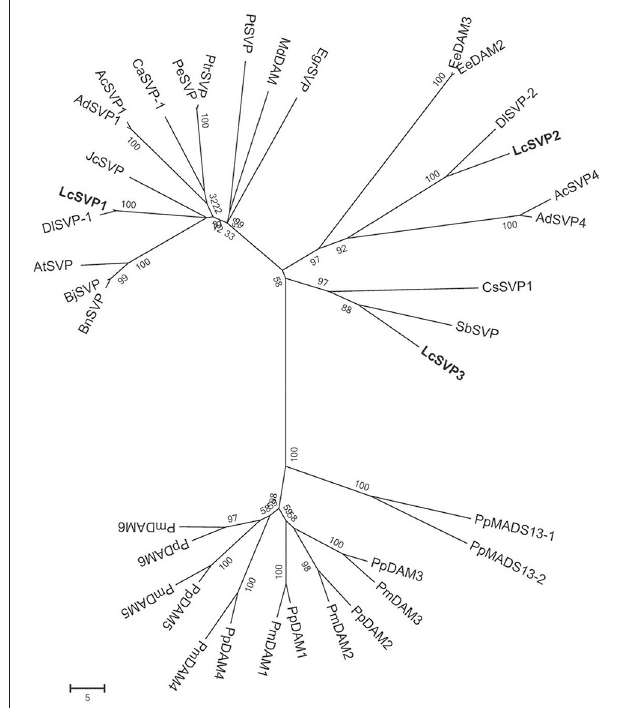
FIGURE 10 | Phylogenetic relationships between LcSVPs and SVPs of other species. The accession numbers of these proteins in the GenBank database are as follows: Actinidia chinensis (AcSVP1; AFA37967; AcSVP4, AFA37970); Actinidia deliciosa (AdSVP1, AFA37963; AdSVP4, AFA37966); Arabidopsis thaliana (AtSVP, AFU85632); Brassica juncea (BjSVP, AFM77905); Brassica napus (BnSVP, AFM77907); Coffea Arabica (CaSVP-1, AHW58026); Camellia sinensis (CsSVP1, AIK35208); Dimocarpus longan (DlSVP-1, AIY25020; DlSVP-2, AIY25021); EeDAM2, ABY60423; Euphorbia